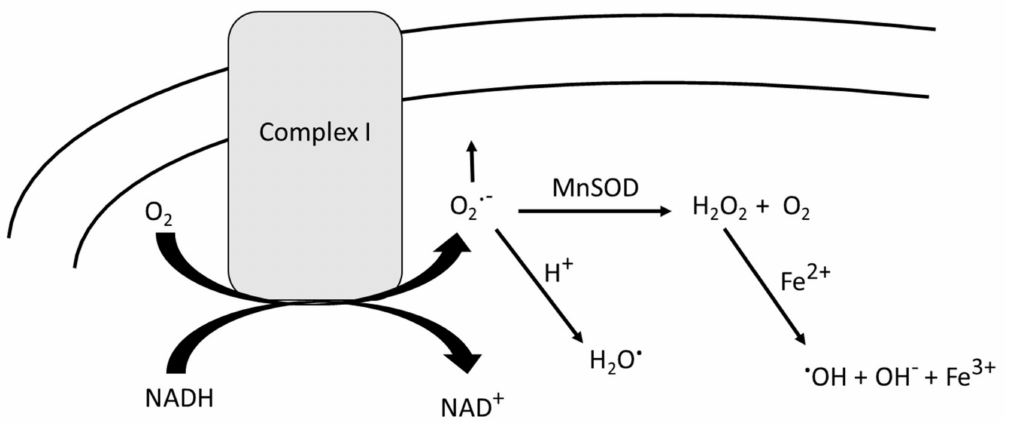
Figure 1. In the process of oxidizing NADH by mitochondrial Complex I, oxygen is partially reduced to superoxide free radical, and a small percentage of leaks out. The protonation of superoxide radical anion leads to a non-charged free radical that can both easily penetrate and even cross the inner membrane lipid bilayer. Matrix-resident manganese superoxide dismutase (MnSOD) catalyzes the disproportionation of superoxide free radical into hydrogen peroxide and oxygen. H 2 O 2 can react with any adventitious Fe 2 + or Cu + to form the highly reactive hydroxyl free radical, which causes oxidative damage to any nearby protein or lipid. Moreover, H 2 O 2 has a zero dipole moment, giving this molecule a non-polar character, which allows penetration into the lipid bilayer where lipid peroxidation may ensue. See the text for more